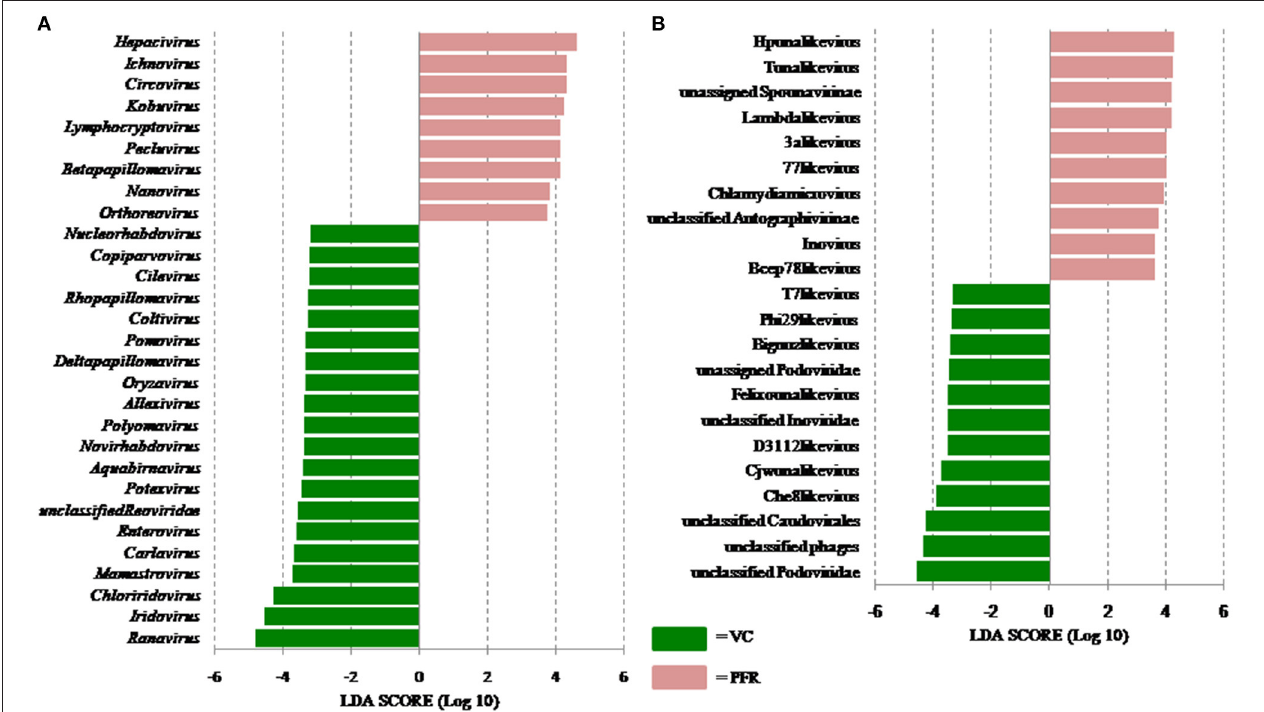
FIGURE 5 | Linear discriminant analysis (LDA) of the virome of VC and PFR. (A) LDA in Eukaryotic viruses and (B) LDA in Bacteriophages. The bars in the figure represent the statistically significant genera as determined by the linear discriminant analysis (LDA) combined with effect size measurements (LEfSe). Peach color bars indicate an increase in the relative abundance of the genera in the PFR group.